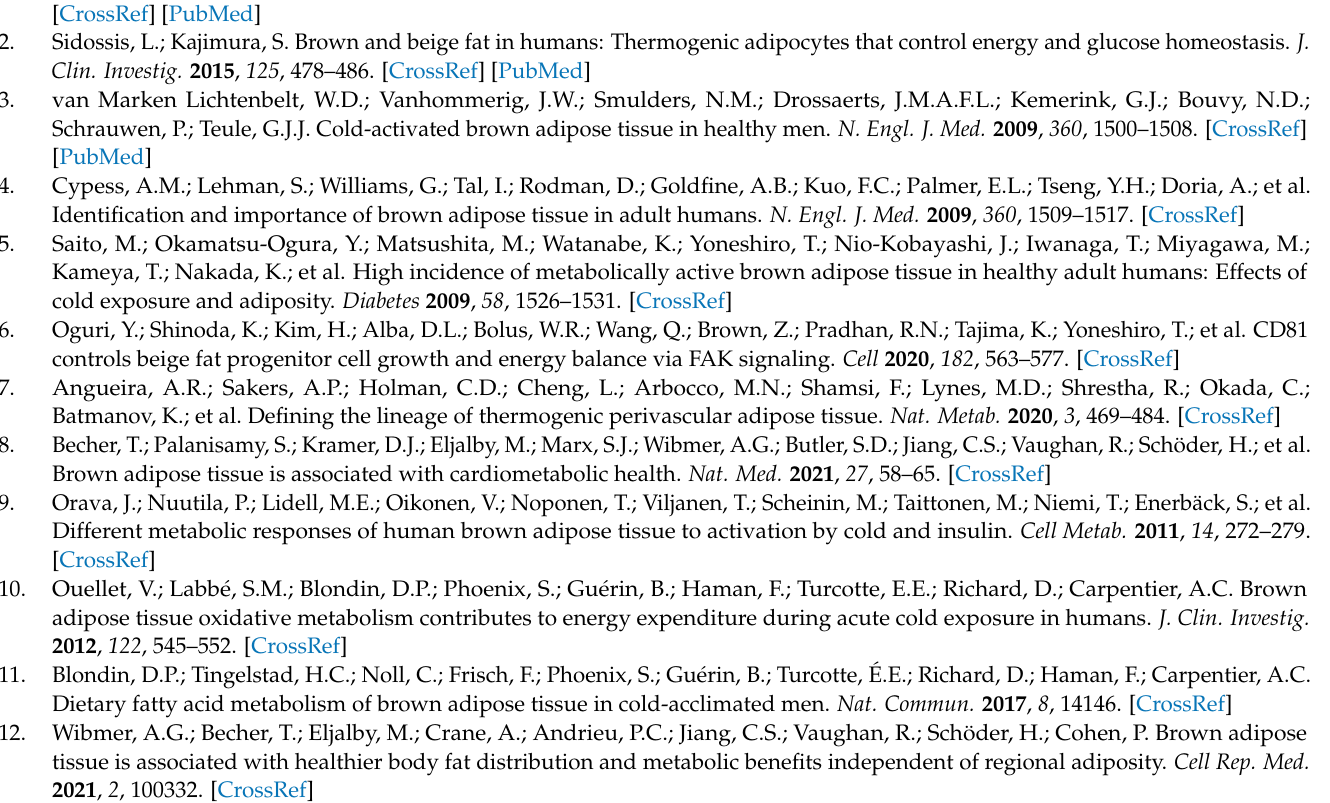
Table S3: Information on human dermal fibroblasts (HDFs) and mesenchymal stem cells (MSCs) used in this study. Table S4: Sequences and product size of primers used for